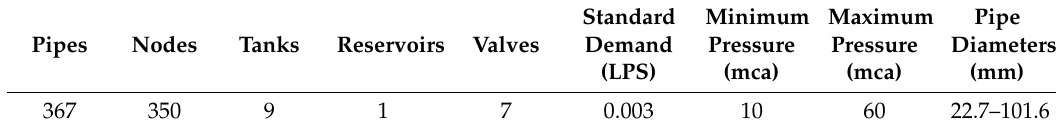
Table 4. Summary of the data for the best solution found for the FRM network